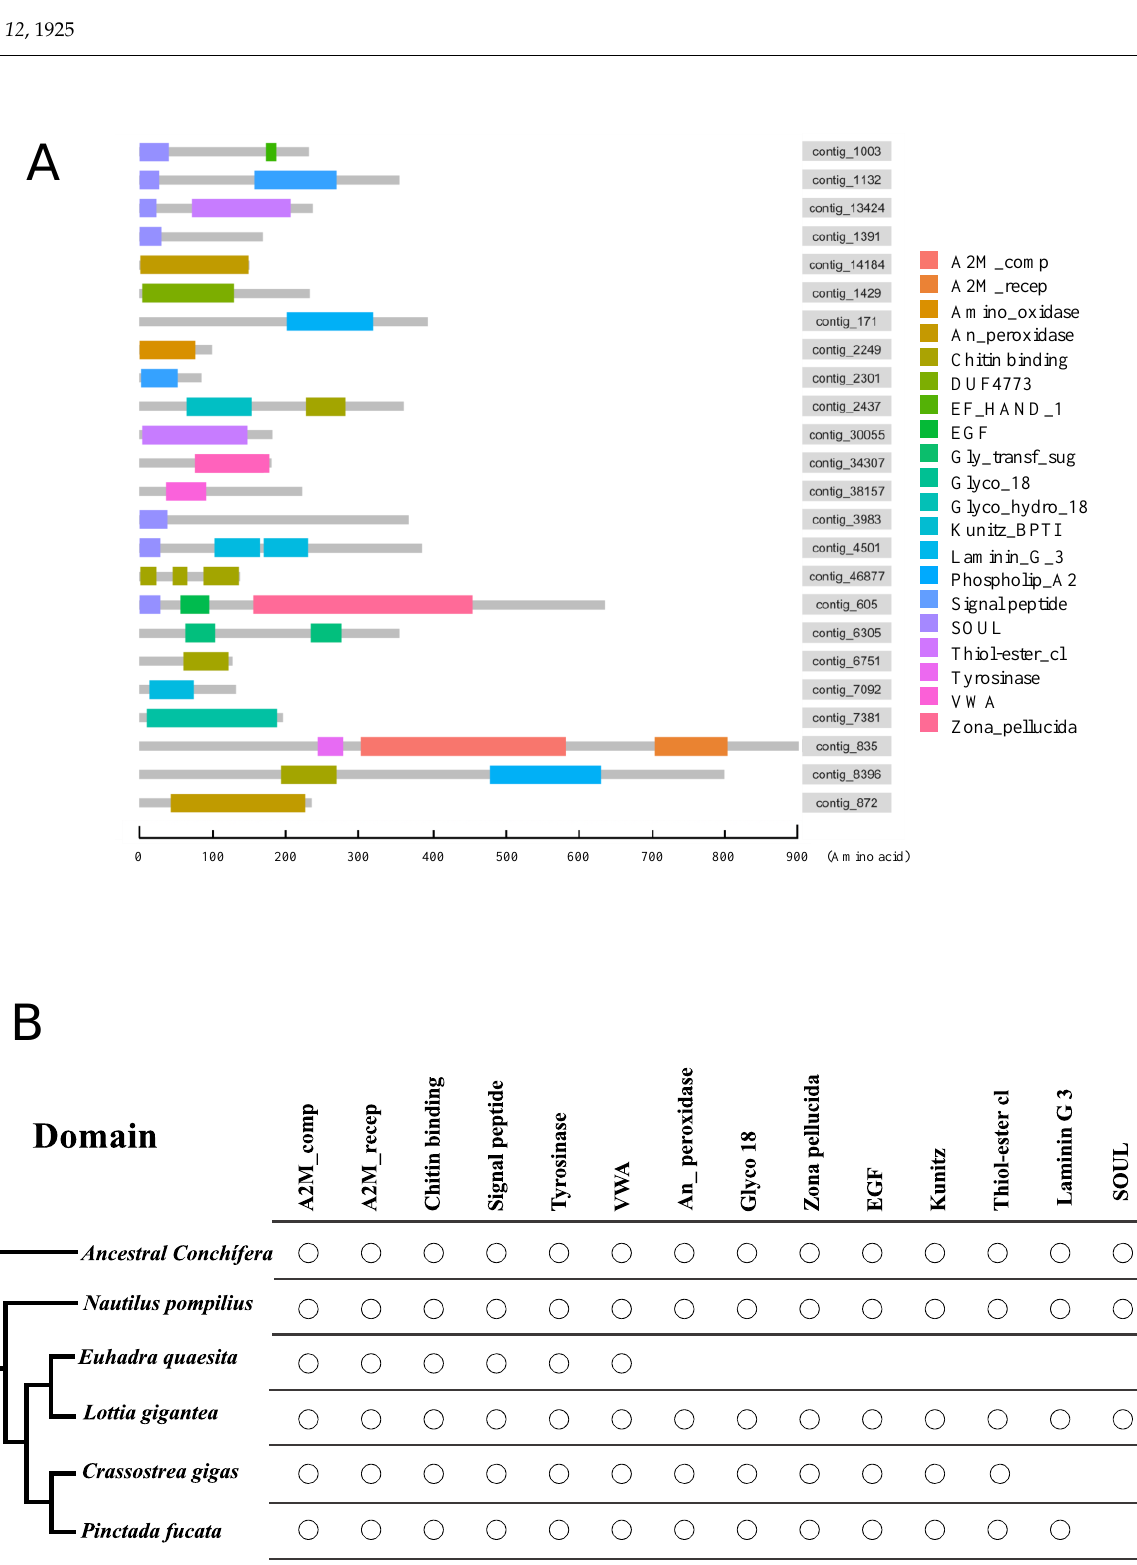
Figure 3. Comparisons of the domains contained in the Shell Matrix Proteins of several Conchiferans for which the data are available. ( A ) Schematic representations of the domains in the Shell Matrix Proteins of Nautilus pompilius . ( B ) Shared domains in the Shell Matrix Proteins of the five Conchiferans ( N. pompilius , Pinctada fucata, Crassostrea gigas, Lottia gigantea and Euhadra quaesita ) compared, mapped on to the phylogeny of the animals. The reconstructed Ancestral Conchiferans most likely had all of the shared